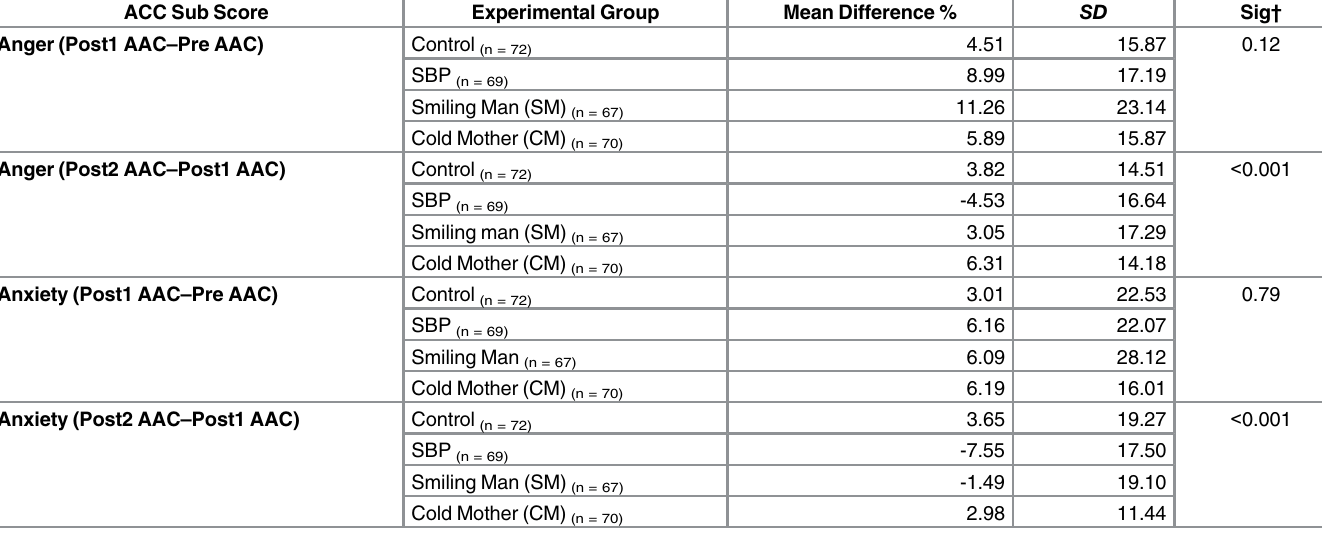
Table 3. Percentage differences between Post1-Pre and Post2-Post1 of the Anger and Anxiety AAC Composite Scores means of the Internet Group. ACC Sub